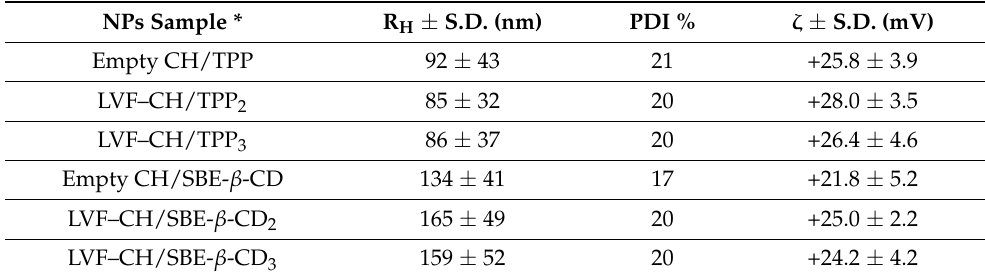
Table 3. Hydrodynamic radius (R H ), polydispersity index (PDI), and zeta potential ( ζ ) of CH NPs loading